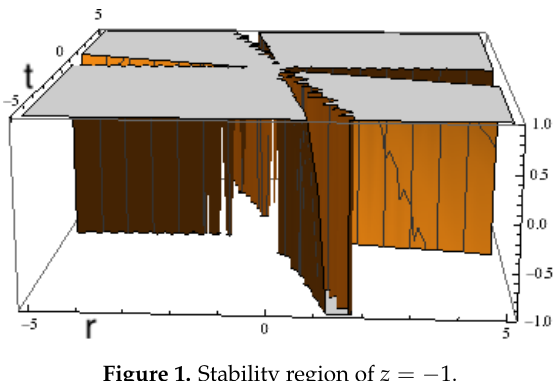
Figure 1. Stability region of z = − 1.